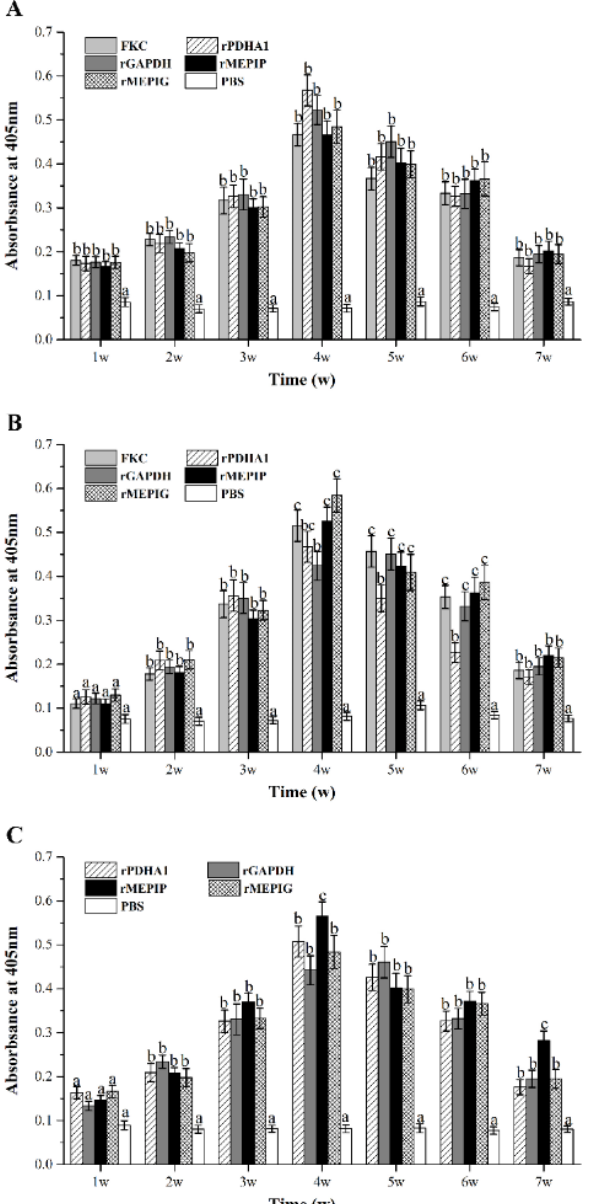
Figure 7. Variations of serum total IgM and specific IgM during 1–7 weeks after FKC, rPDHA1, rGAPDH, rMEPIP, rMEPIG, PBS immunization determined by ELISA. ( A ) Variations of serum total IgM. ( B ) Variations of specific IgM against S. iniae . ( C ) Variations of specific IgM against rPDHA1 and rGAPDH. Values are shown as means ± SEM of three fish. Different letters above the bar represent statistical differences ( p <